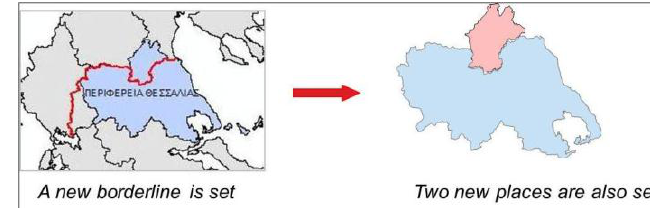
Figure 6. A spatial entity’s change and its consequences to other